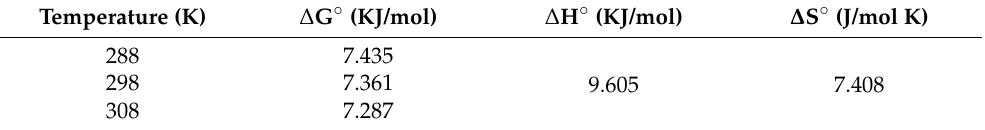
Table 5. Thermodynamic parameters for the adsorption of enrofloxacin onto P. koidzumii